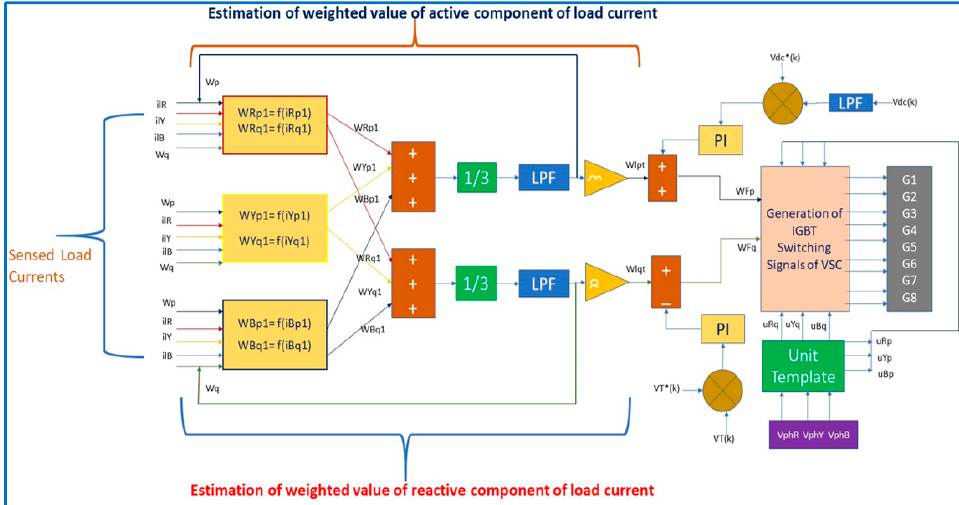
Figure 6. Block diagram of the ANN controller.